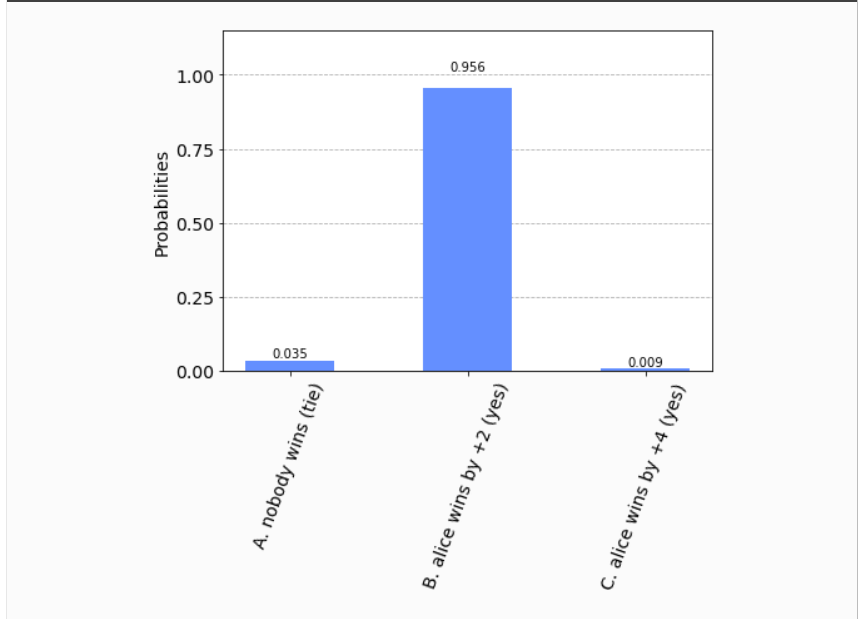
Figure 5. The possible outcomes and their probabilities when r A = r B =